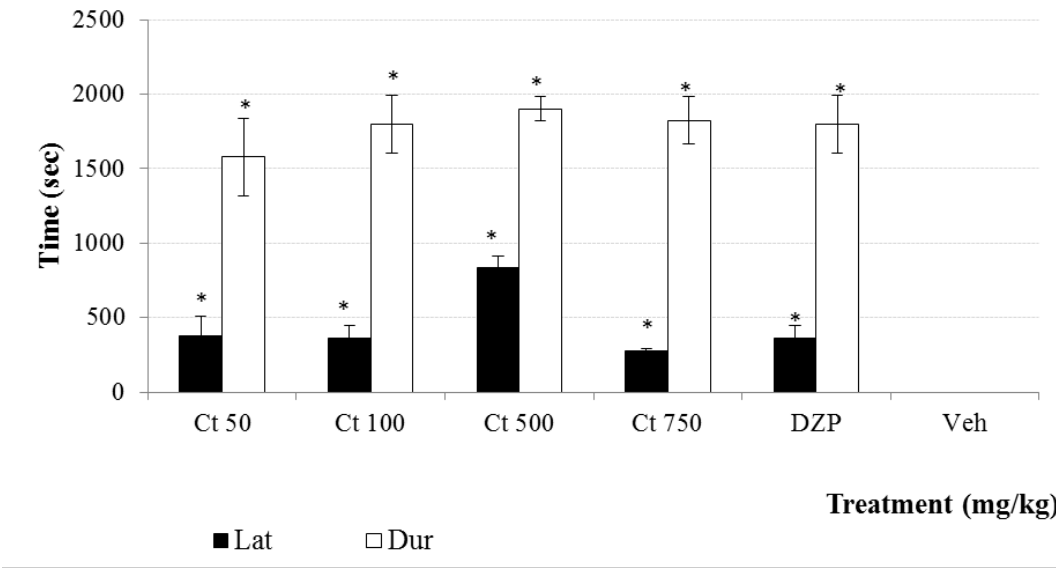
Figure 3. Effect produced by different doses (50, 100, 500 and 750 mg/kg, p.o. ) of Ct extract from C. tenuiflora on the latency and duration of hypnosis induced by sodium pentobarbital (40 mg/kg, sub hypnotic dose). Results are presented as means ± SD. * p < 0.05, as compared with the control group. (ANOVA one way following by Dunnet test); n = 6 mice per group. Lat = latency, Dur = duration, DZP = Diazepam, Veh = Tween 20,